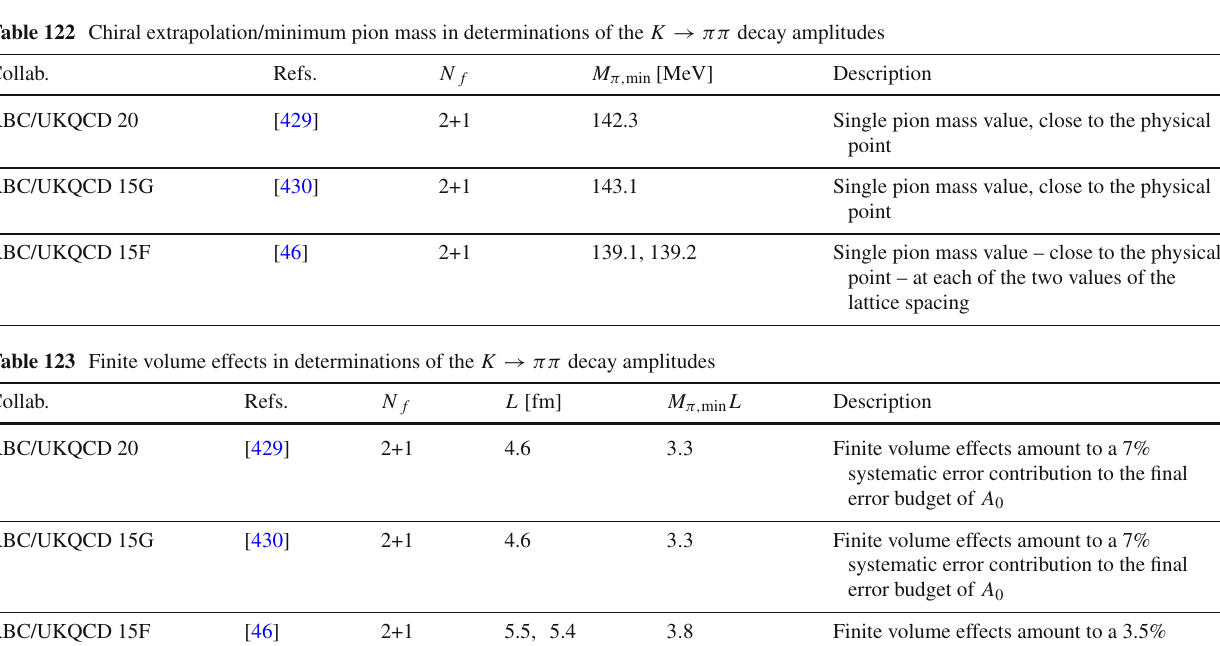
with the extrapolation to the continuum limit is negligible with respect to the statistical errors